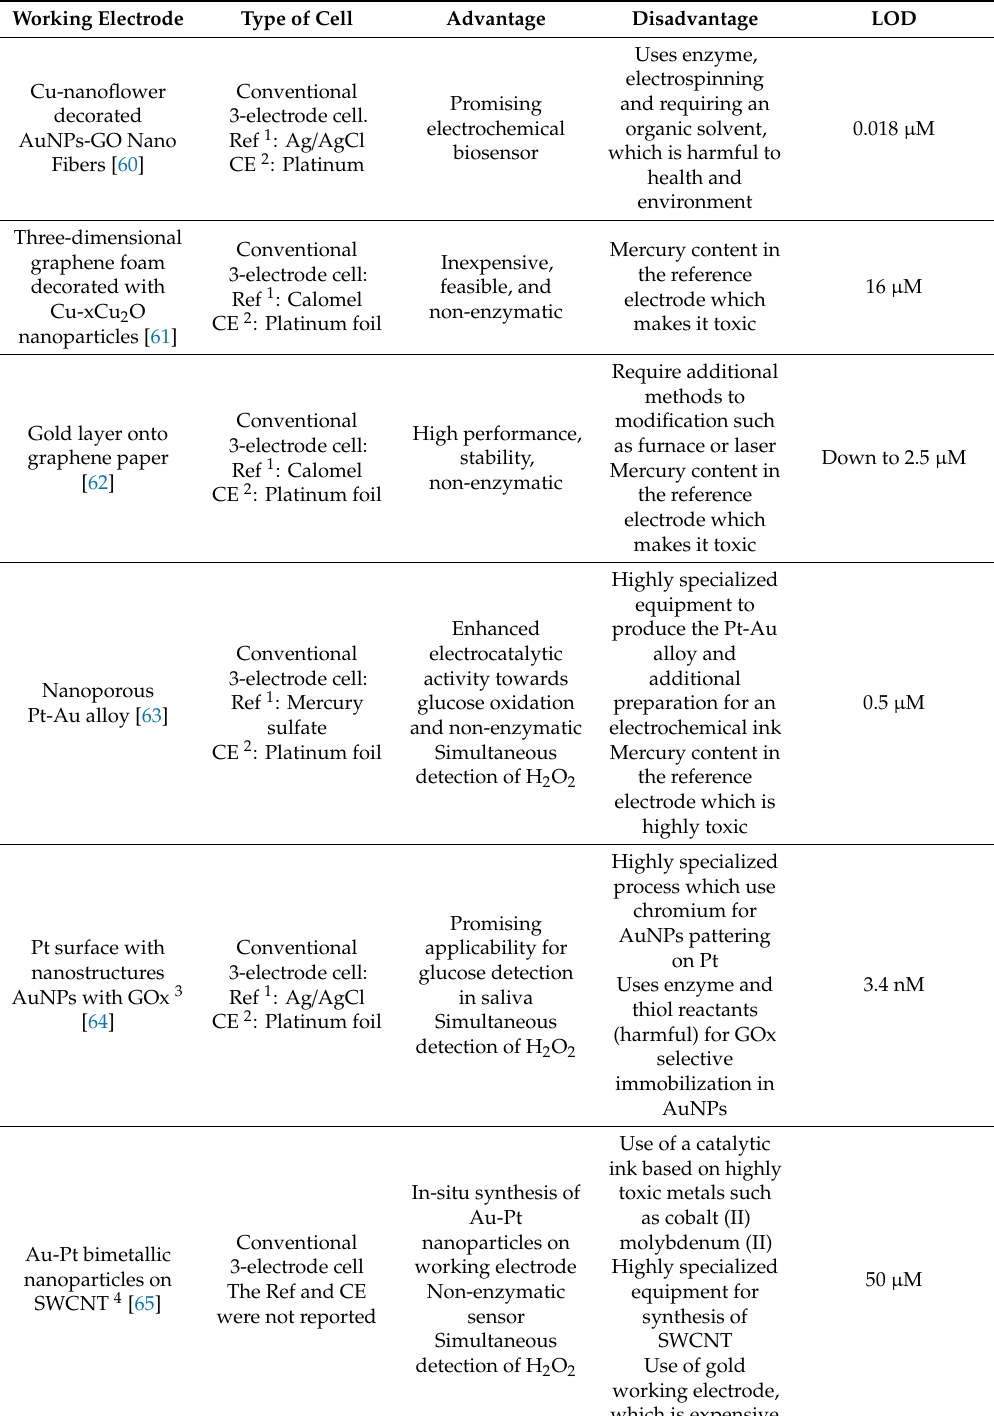
Table 1. Comparison of di ff erent electrochemical sensors for detecting glucose. Working Electrode Type of Cell Advantage Disadvantage LOD